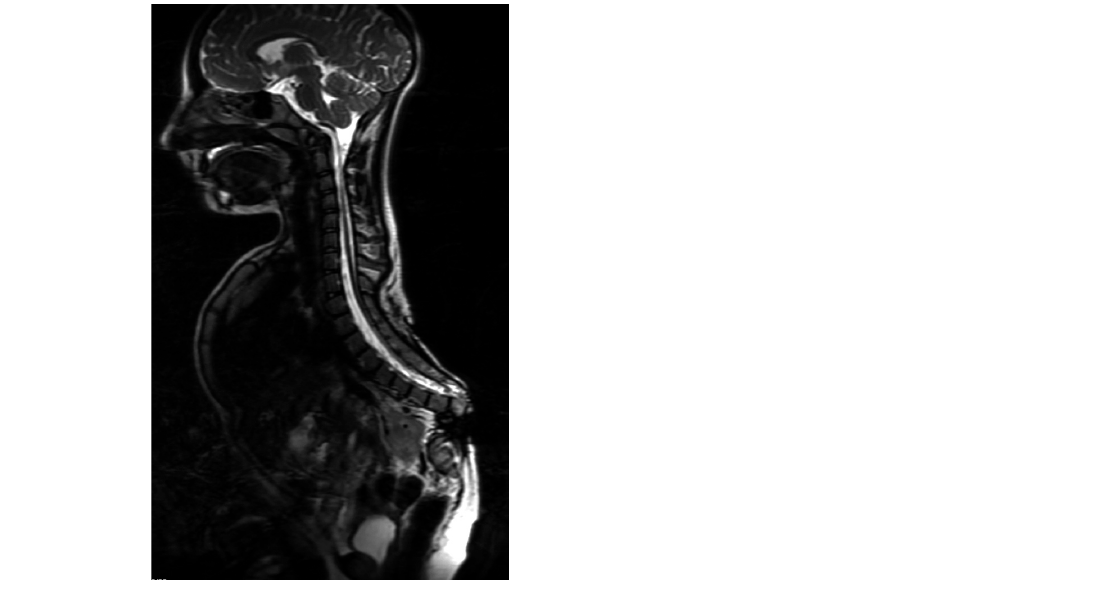
Figure 7. MRI scan. Atypical CRS: absence of lower lumbar vertebra and sacral hypoplasia. Correct diagnosis of the defect, with all its components, should be made as soon as Patients with CRS usually have normal cognitive abilities, hearing and speech possible, even in prenatal period, to allow for timely planning of the appropriate treat- ment which is primarily focused on the treatment of problems that directly threaten pa- tient(cid:31)s life.